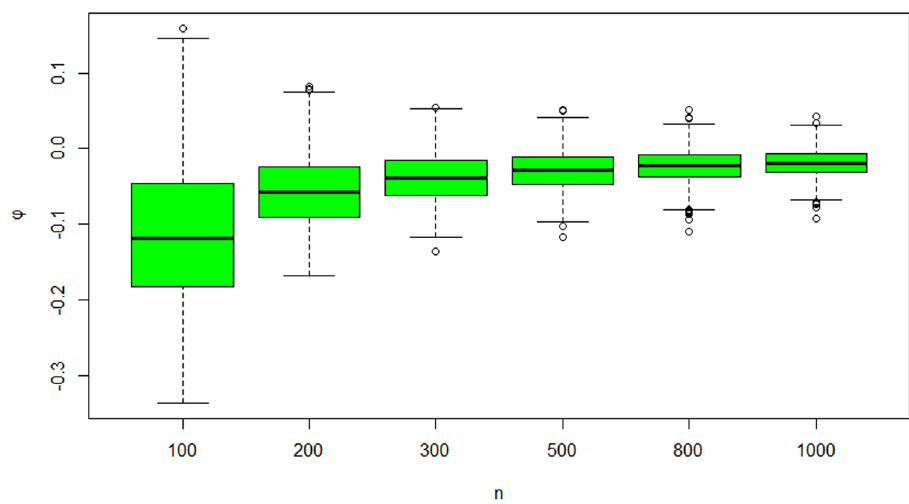
with = β 2 and = β 4 . 0 1